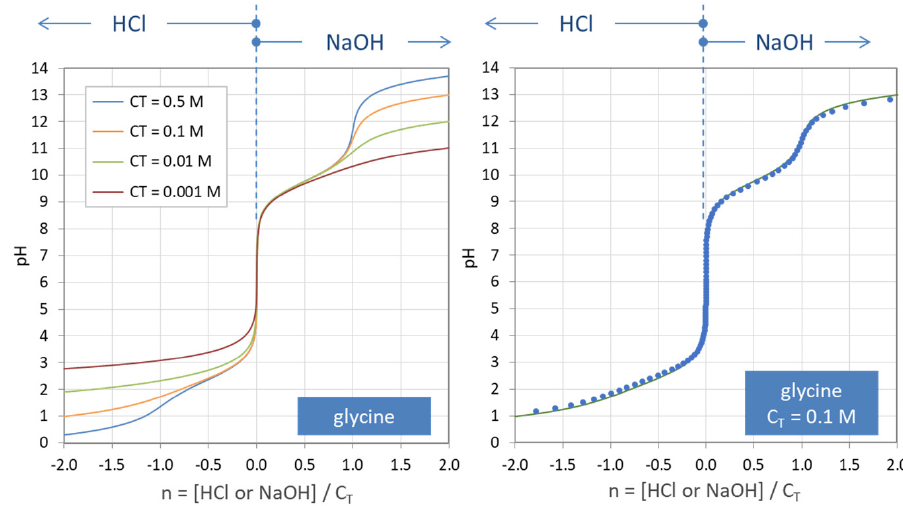
Figure 35. Titration curves n = n(pH) for the amino acid glycine. ( Left ): calculations based on Equation (138) for four amounts of C T . ( Right ): comparison with numerical program PhreeqC (dots).